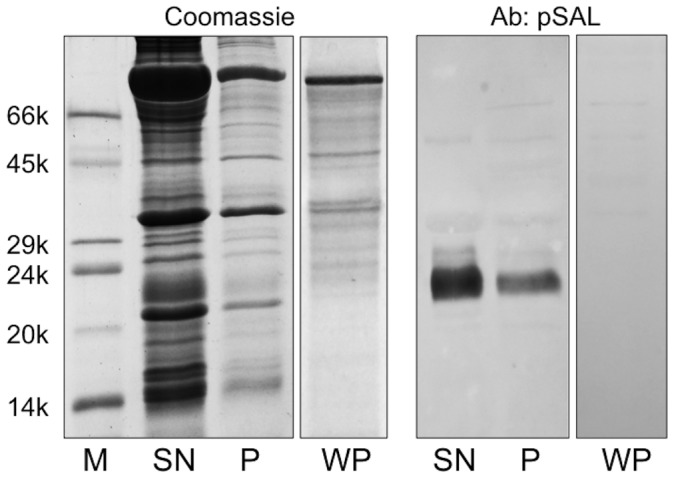
SDS-PAGE analysis of rabbit sperm and corresponding Western blotting.SN, soluble fraction; P, sperm cells; WP, sperm cells after washing three times with buffer. A strong cross-reactivity with a polyclonal antiserum raised against pig SAL [19] was observed for a protein migrating at about 23 kDa. Staining was much stronger in the soluble fraction; the weak reactivity observed for the sperm cells disappeared after washing the cells, thus indicating the absence of the protein in this sample.